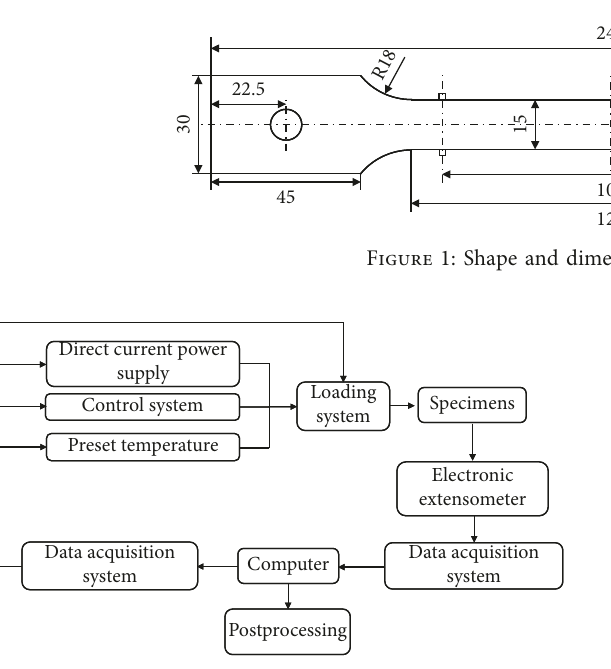
Figure 2: Composition of the test system.